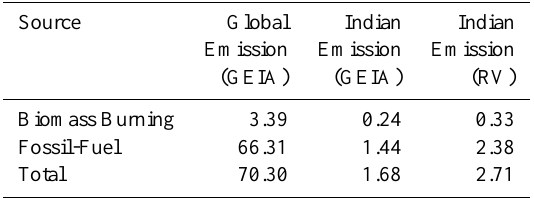
Table 1. Global annual sulphur emissions in the model (TgSyr − 1 ). Source